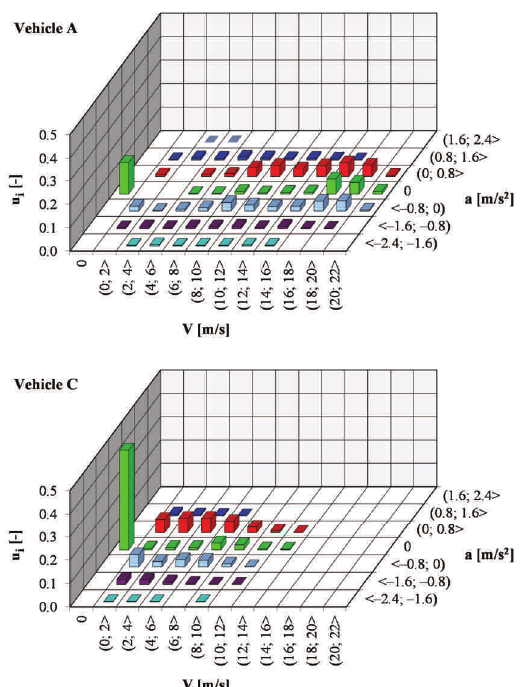
Fig. 4. Shares of vehicles operating time in speed and acceleration com- partments during road